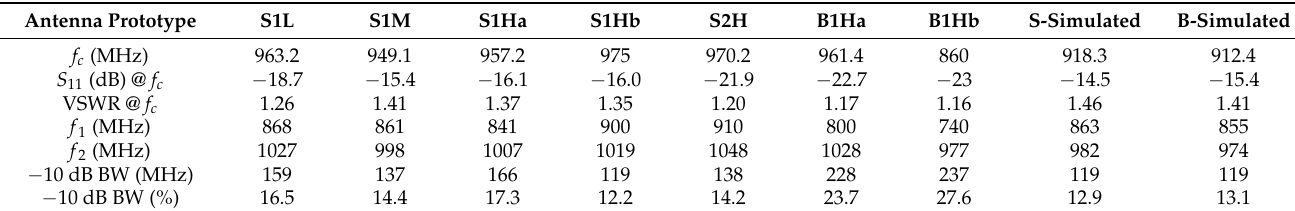
Table 2. Measured and simulated characteristics of the antenna prototypes in free